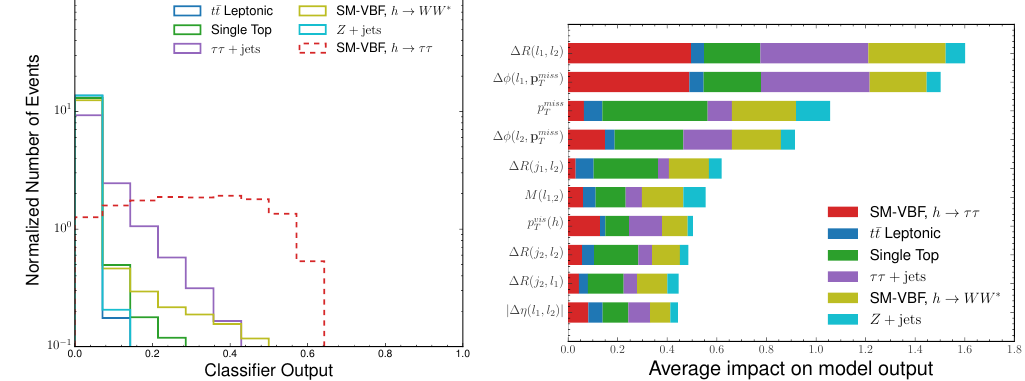
Figure 8 . Same as figure 5 for leptonic